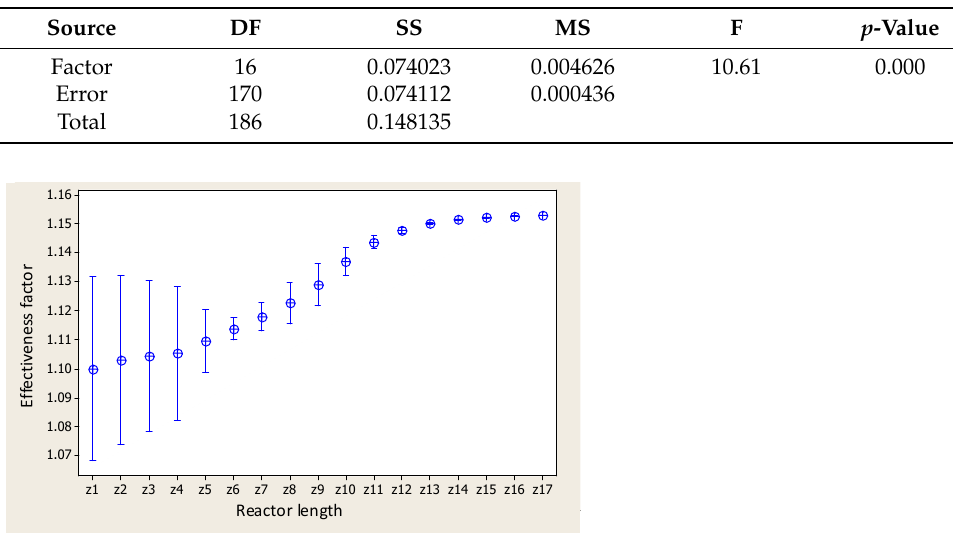
Table 3. Analysis of variance of the effectiveness factor versus the length reactor.